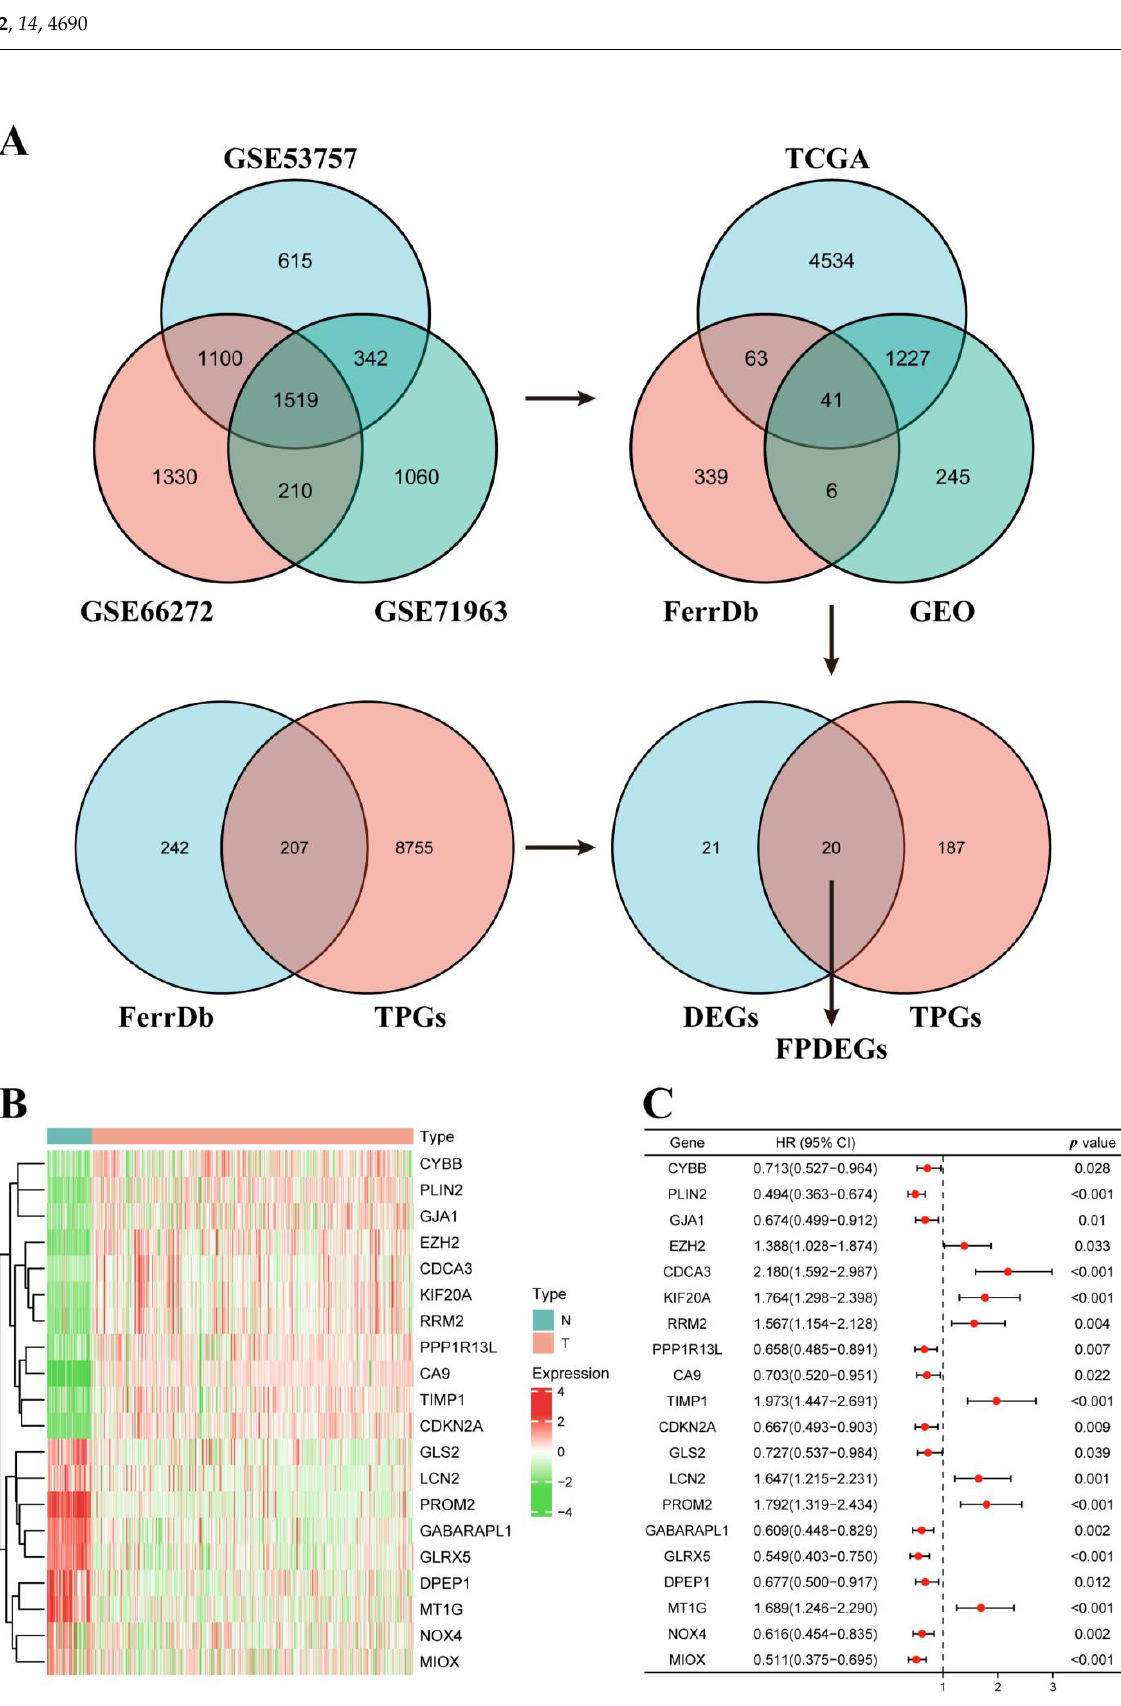
Figure 2. Identification of FPDEGs. ( A ) Process of identifying FPDEGs via Venn. ( B ) Heatmap showing expression of twenty FPDEGs in KIRC cohort of TCGA database. ( C ) Forest plot showing twenty FPDEGs identified by univariate Cox regression analysis based on OS.